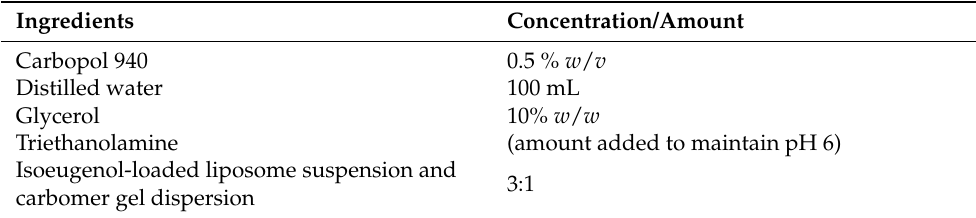
Table 3. The composition of the gel